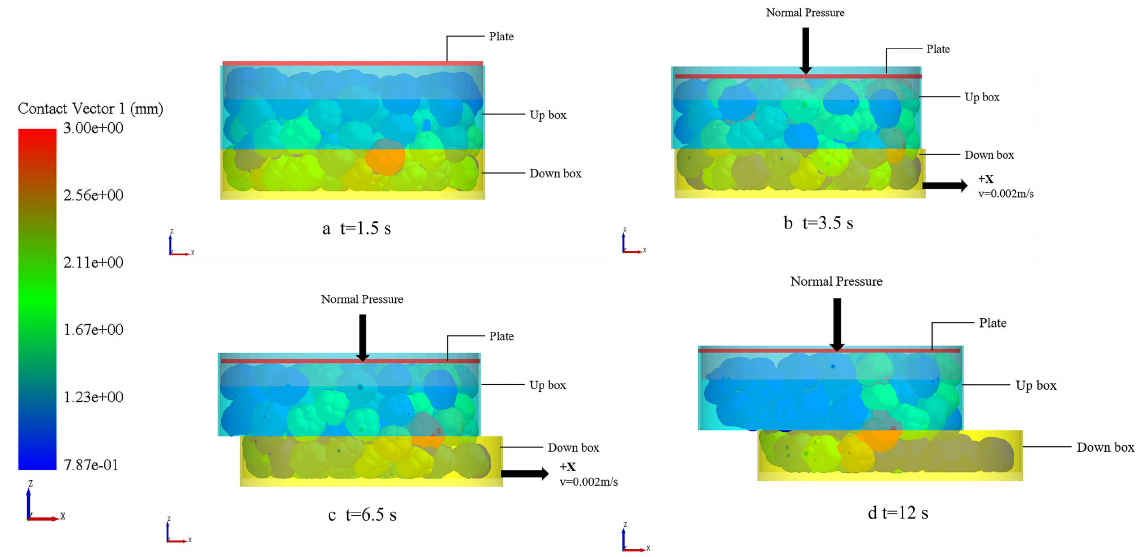
Figure 12. Snapshots of the simulation of the direct shear test of Jinong 1 seeds using the 9-sphere model [22].